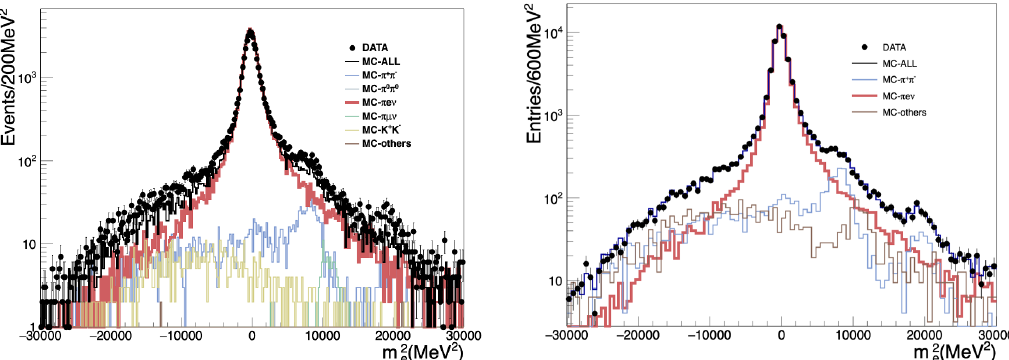
distribution for data, MC signal and background before the fit (left) and Figure 6 . The m 2 e comparison of data with the result of the fit (right).